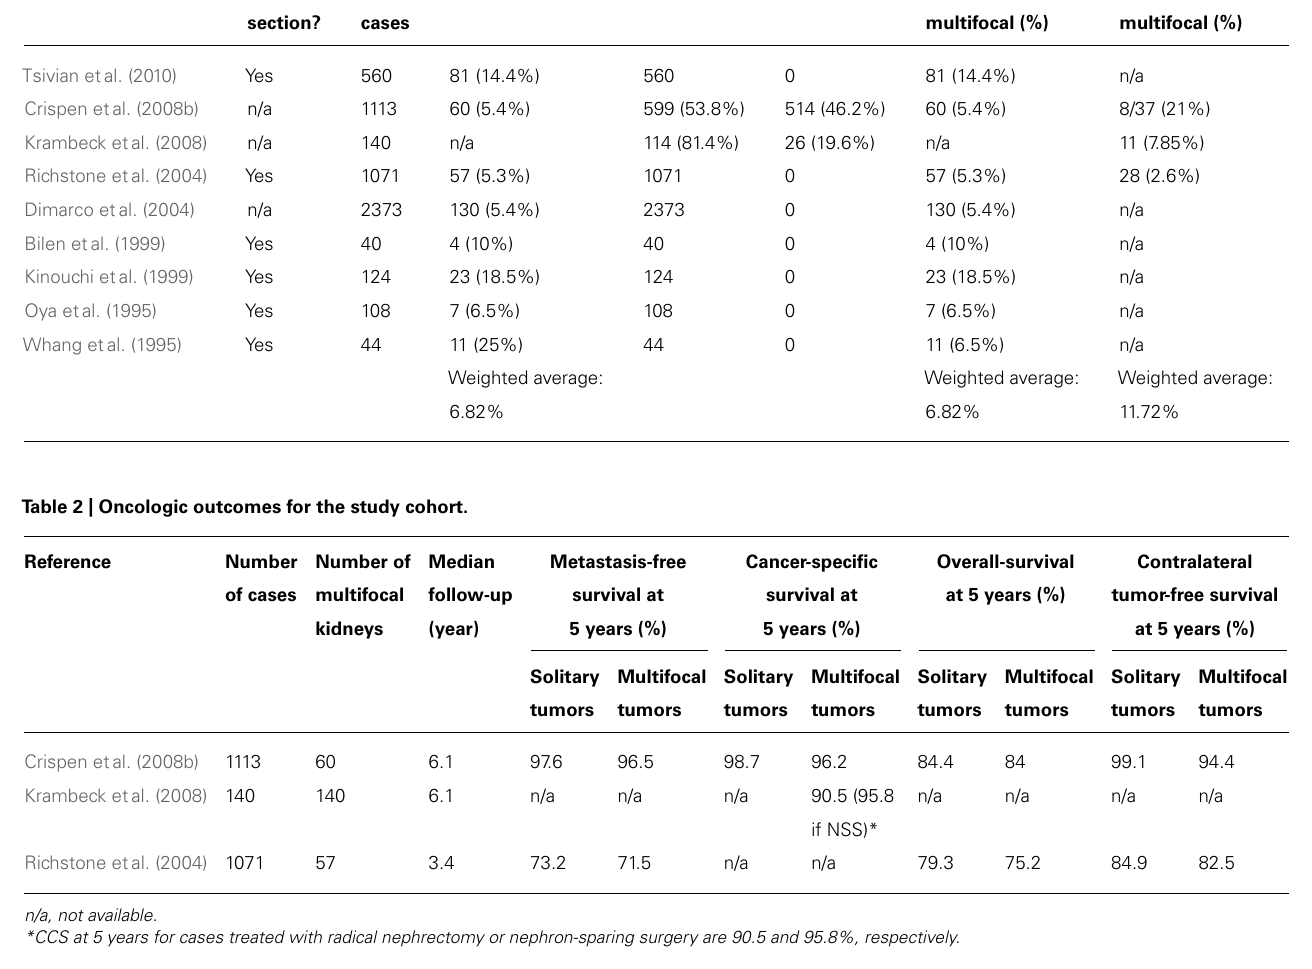
Table 1 | List of peer reviewed articles included for analysis.